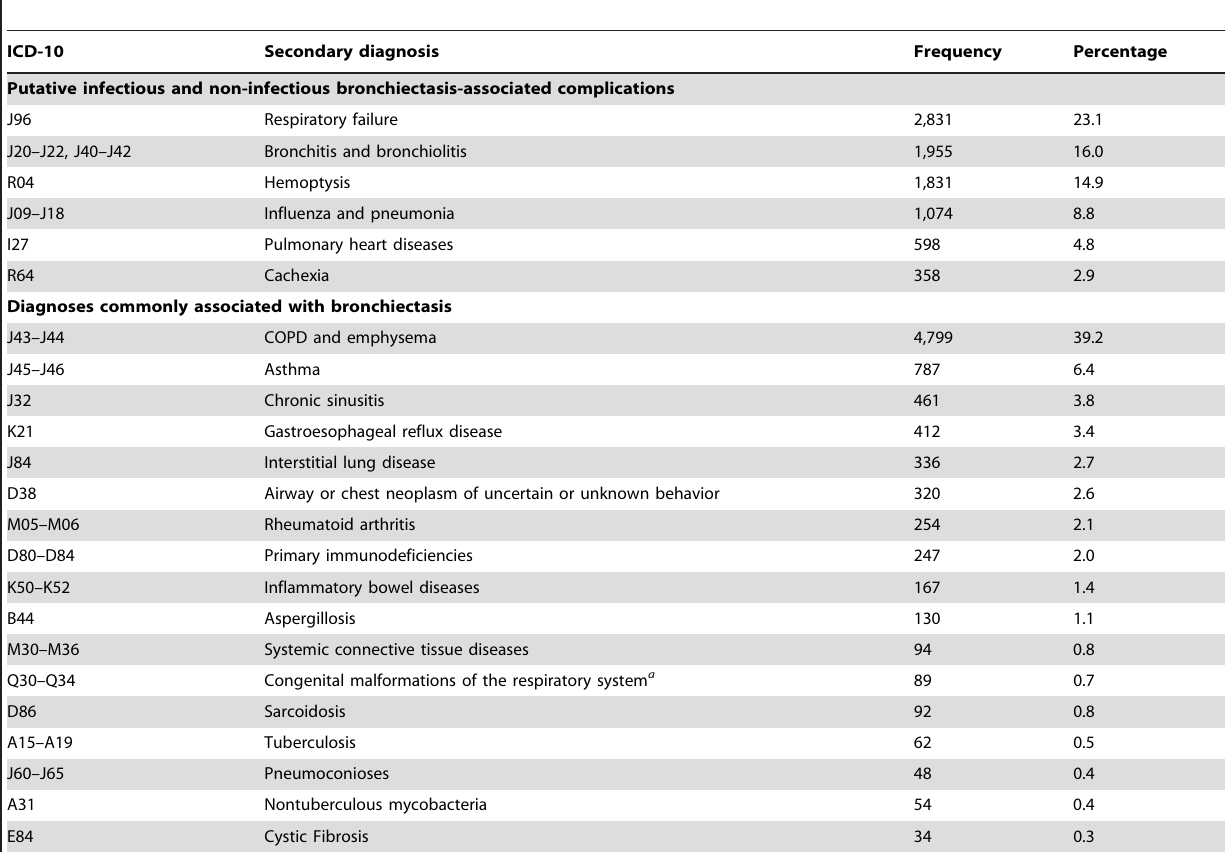
Table 2. Secondary diagnoses when bronchiectasis is the primary diagnosis during hospitalization, classified by putative infectious and non-infectious complications as well as diagnoses commonly associated with bronchiectasis (n=12,251).